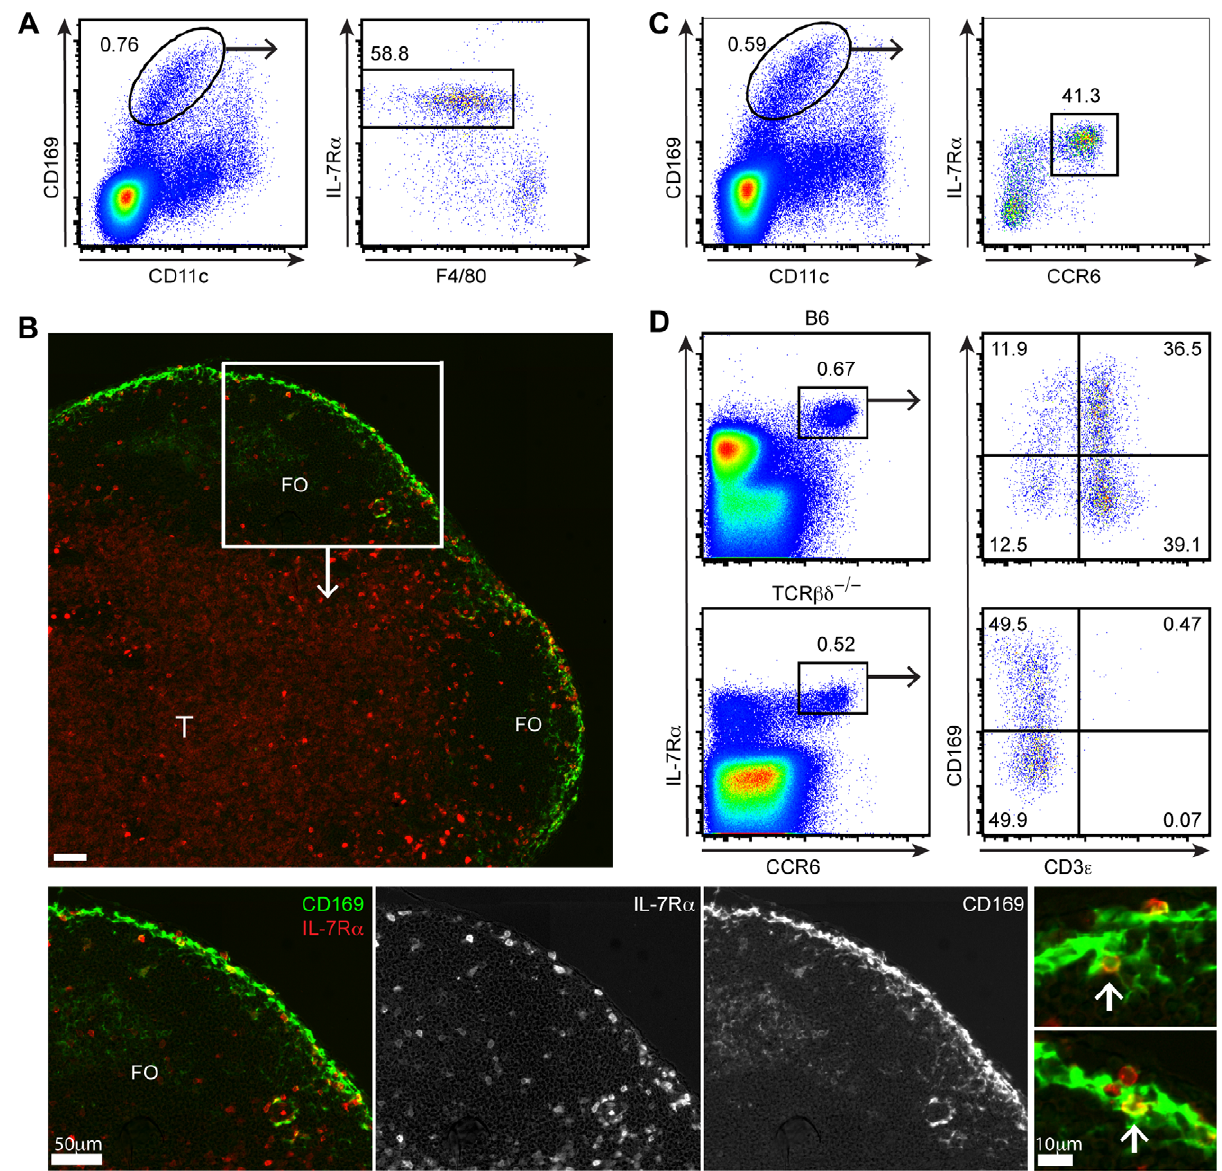
Figure 1. Detection of CD169 + IL-7R a hi CCR6 + lymphocytes in digested lymph node tissue. (A) Flow cytometric detection of IL-7R a expression on CD169 + CD11c lo cells from digested lymph nodes. (B) Immunofluorescence microscopy of a lymph node section stained with anti- CD169 and anti-IL-7R a monoclonal antibodies. Enlargements (bottom, far right) show examples of IL-7R a + cells (white arrows) closely associated with CD169 + SSMs. FO, follicle; T, T zone. (C) Flow cytometric analysis showing CD169 + CD11c lo cells contain a population of IL-7R a hi CCR6 + cells. All data in A–C are representative of at least three independent experiments. (D) Flow cytometric analysis of digested lymph node cells from a control and TCR bd -deficient mouse. IL-7R a hi CCR6 + cells gated from total cells express CD169 on a fraction of both CD3e + and CD3e 2 cells. Data are representative of at least three independent experiments (control mice) and one experiment in which a TCR bd -deficient mouse was analyzed. doi:10.1371/journal.pone.0038258.g001 (Figure 3A, B). Most CD169 + IL-7R a hi CCR6 + cells had a small area of CD169 staining, while approximately 15% had a large area of staining (Figure 3B). CD169 + IL-7R a hi CCR6 + cells in the